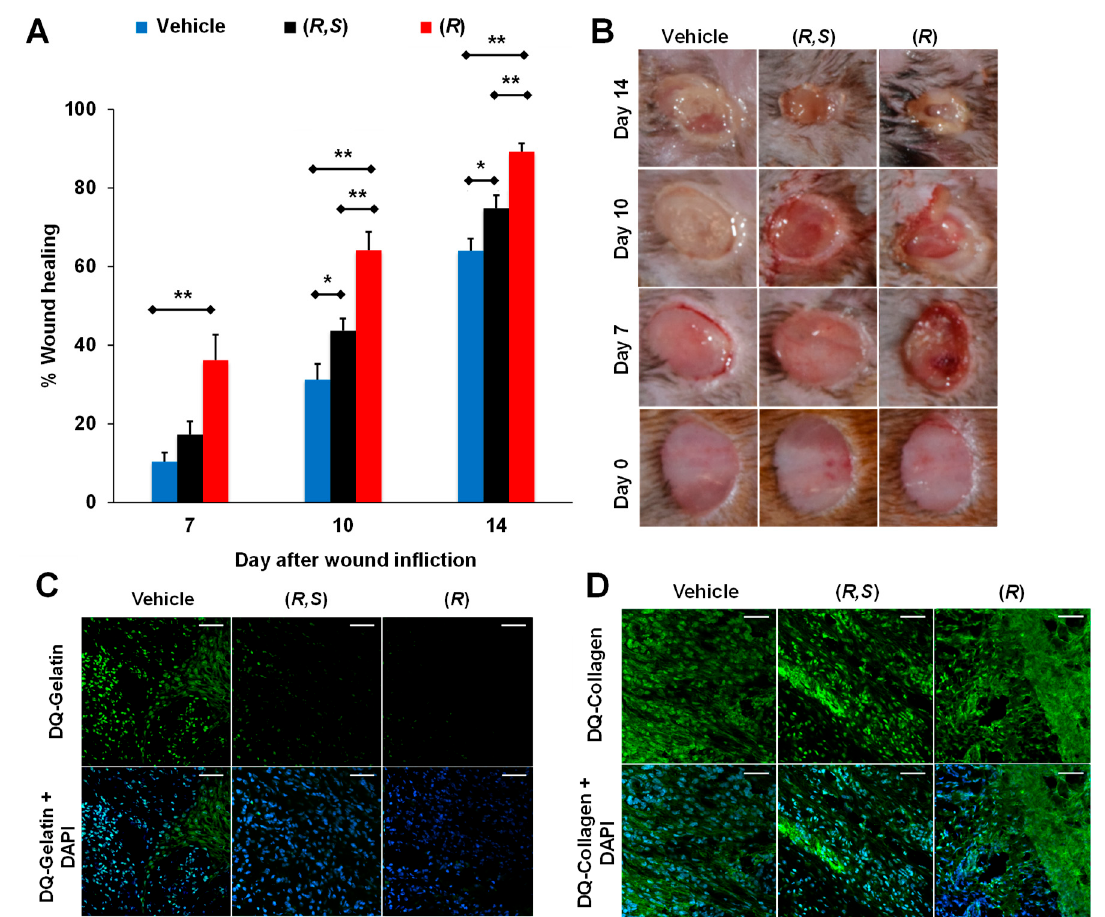
Figure 6. ( R )-ND-336 accelerates wound healing faster than ( R,S )-ND-336 in diabetic mice. Topical treatment with ( R )-, or ( R,S )-ND-336 at 50 μ g/wound/day for 14 days or vehicle (water). ( A ) Wound healing; mean ± SEM, n = 7 mice/group/time point for vehicle, ( R,S )-ND-336, n = 8/time point for ( R )- ND-336, * p < 0.05, ** p < 0.01 by Mann − Whitney U two-tailed test. ( B ) Representative wound images. ( C ) In-situ zymography of the wounds with DQ-gelatin shows that ( R )-ND-336 inhibits MMP-9 better than ( R,S )-ND-336; n = 3 mice/group. The bottom row shows merged images with DAPI nuclear DNA staining, 40× lens (scale bars, 50 μ m). ( D ) In-situ zymography with DQ-collagen indicates that ( R,S )- and ( R )-ND-336 do not inhibit MMP-8; n = 3 mice/group. Adapted from Nguyen et al. [48].